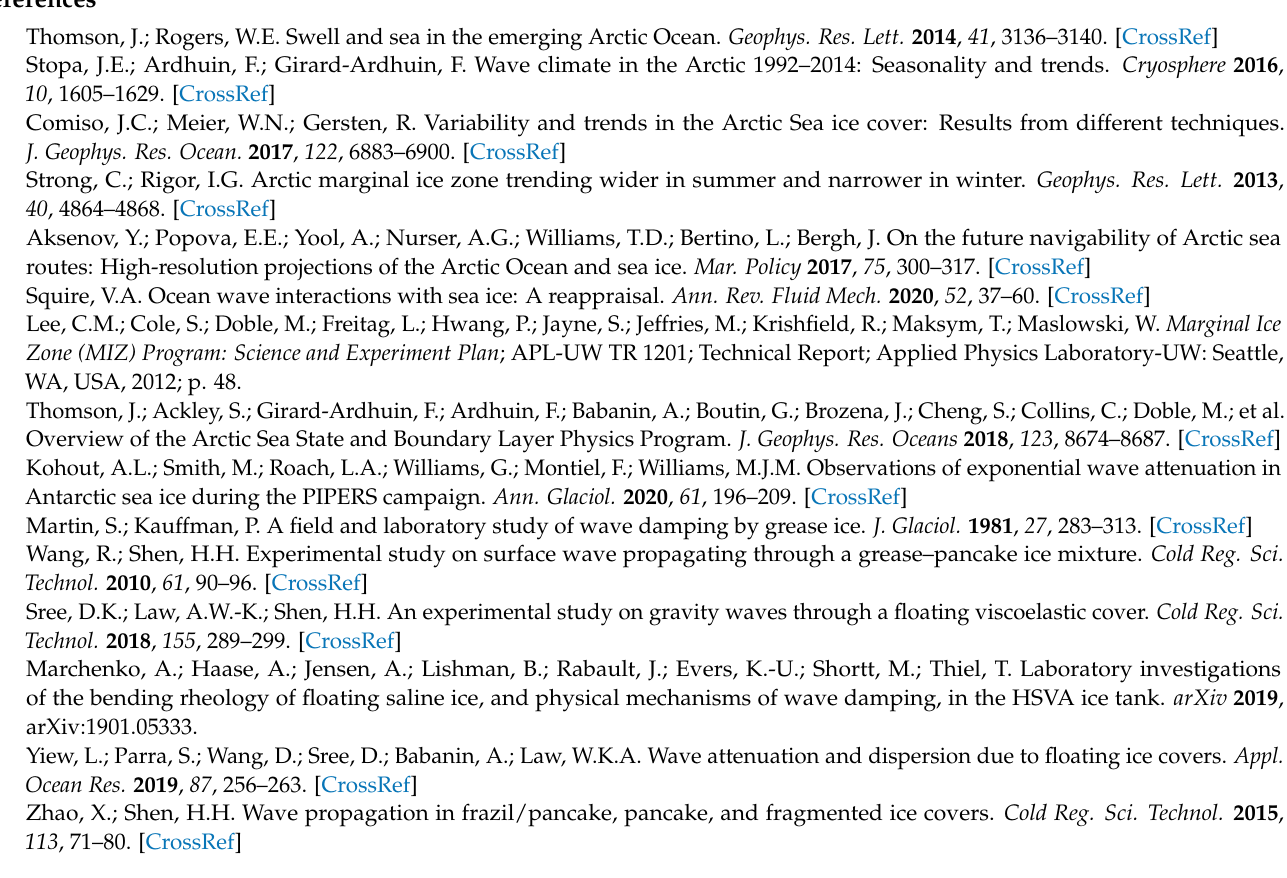
From Figure 6, it is clear that k r ≈ 4.0 m − 1 for the 1-s waves of this case. Thus, we expect wave velocity to have attenuated by a factor of approximately e k r z = e 4.0 · ( − 0.1 ) ≈ 0.67 at 10-cm depth, great enough to be clearly